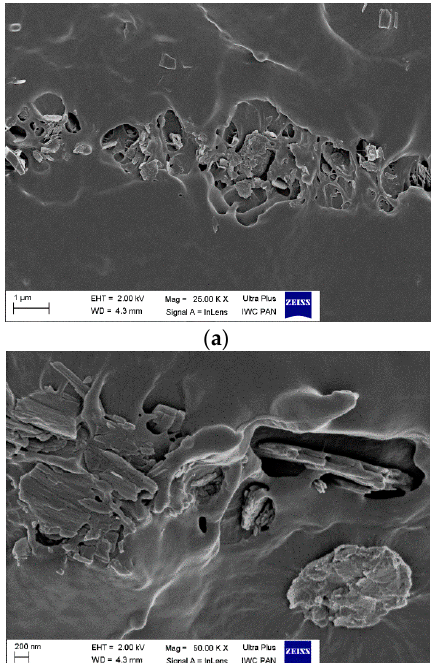
Figure 13. Tan δ of ( a ) NBR and ( b ) EPM composites filled with hybrid pigments as a function of temperature.